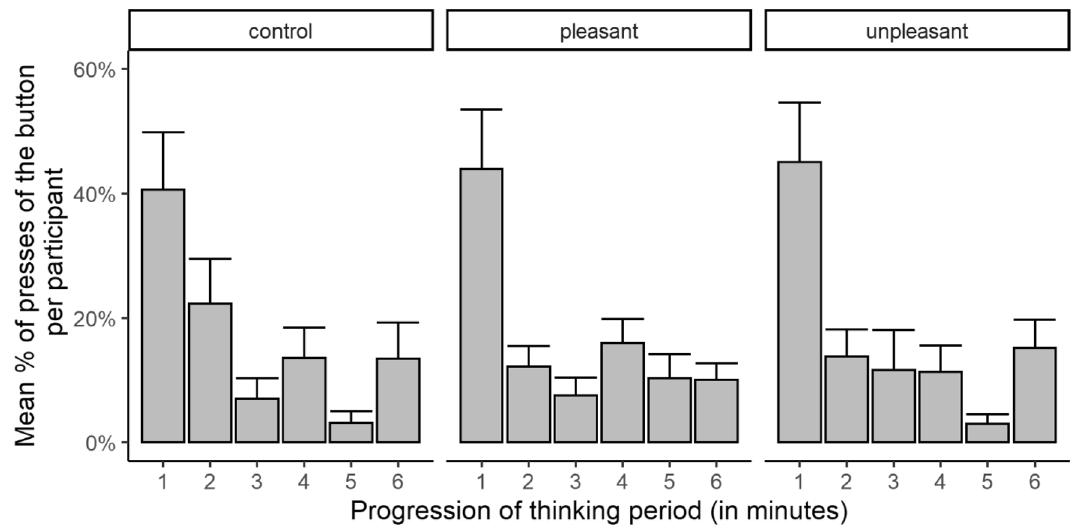
Figure 6. Rate of button presses as a function of time in each thinking aid condition. Error bars show the standard error. Subjects without button presses and nine subjects with outlier values were not included in the counts (valid n s = 15, 16, and 14 in the control, pleasant, and unpleasant conditions, respectively).